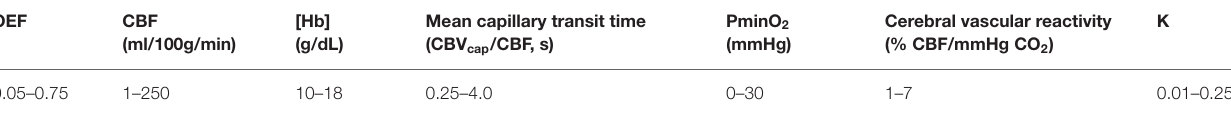
TABLE 1 | Range of physiological parameters used in the dc-fMRI data simulations for training of the machine learning